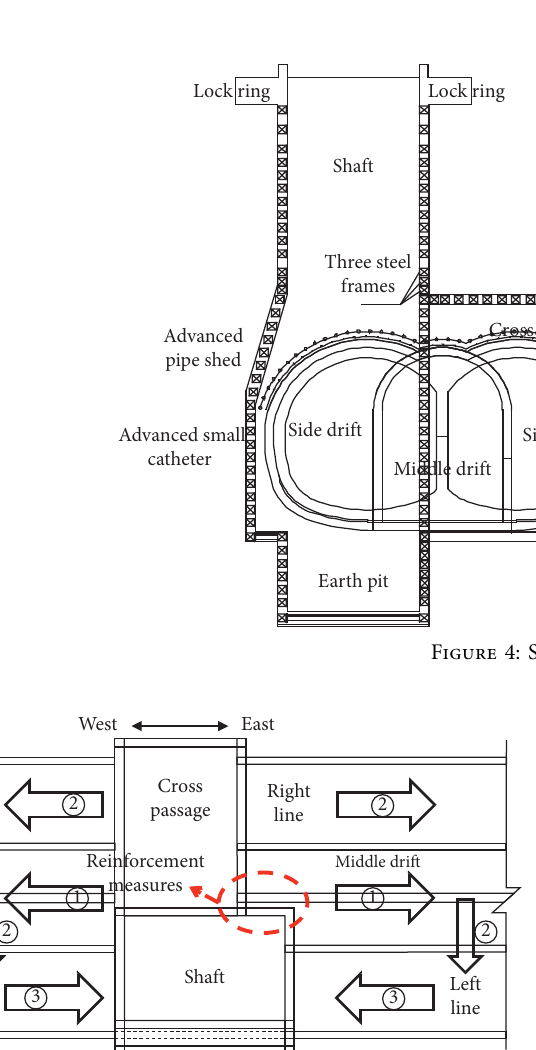
Figure 5: Opening ingate from shaft to east and standard section.